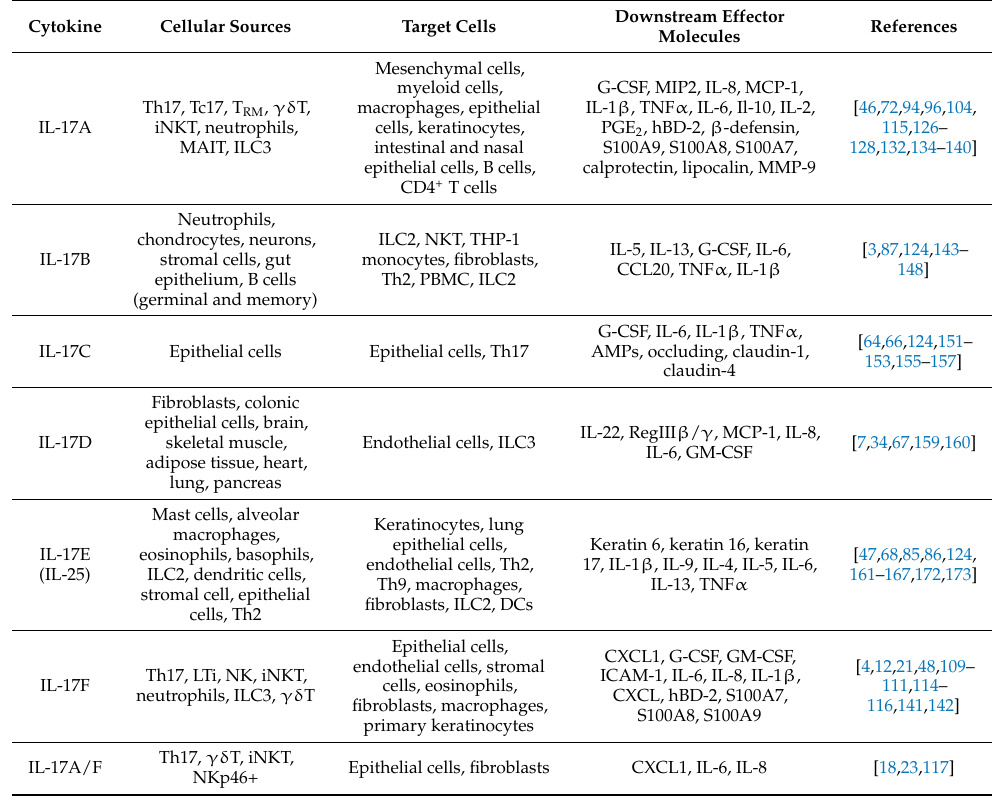
Table 1. IL-17 cytokine family producing cells, targets, and effector molecules. Cytokine Cellular Sources Target